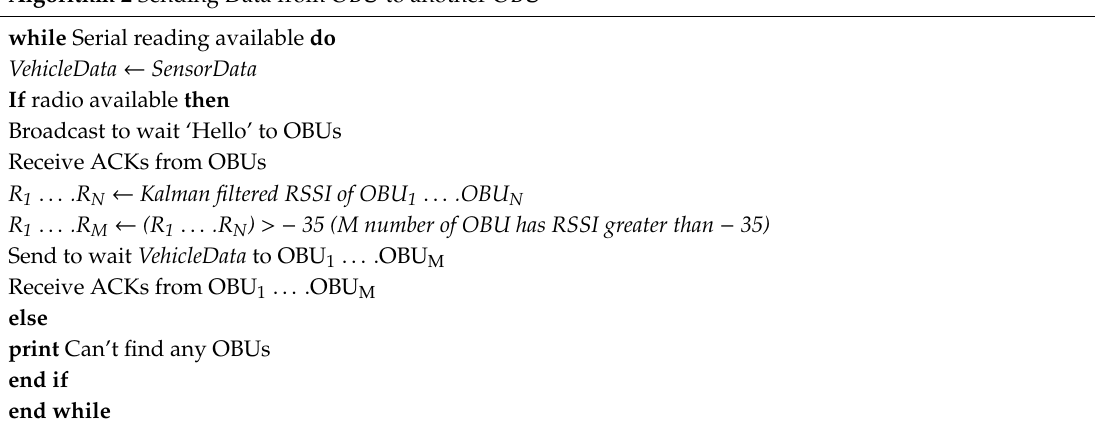
Algorithm 2 Sending Data from OBU to another